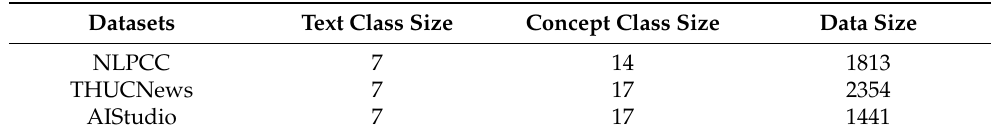
Table 1. Detail of the experimental